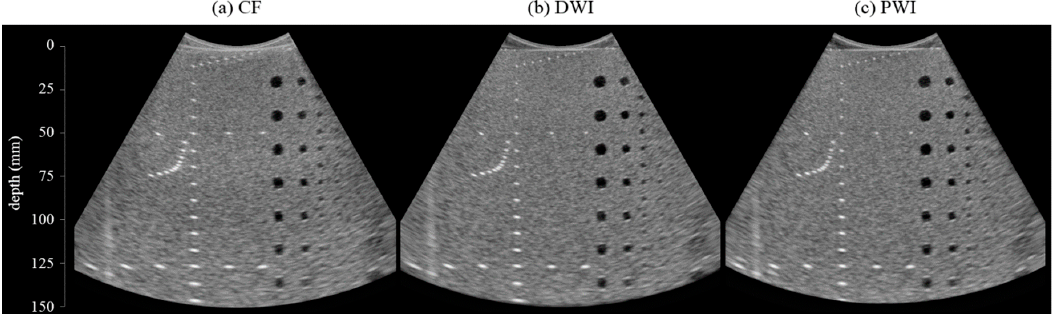
Figure 2. Phantom image set reconstructed by using ( a ) CF, ( b ) DWI, and ( c ) PWI. The enlarged images of point and cyst targets are shown in Figures 3 and 4.